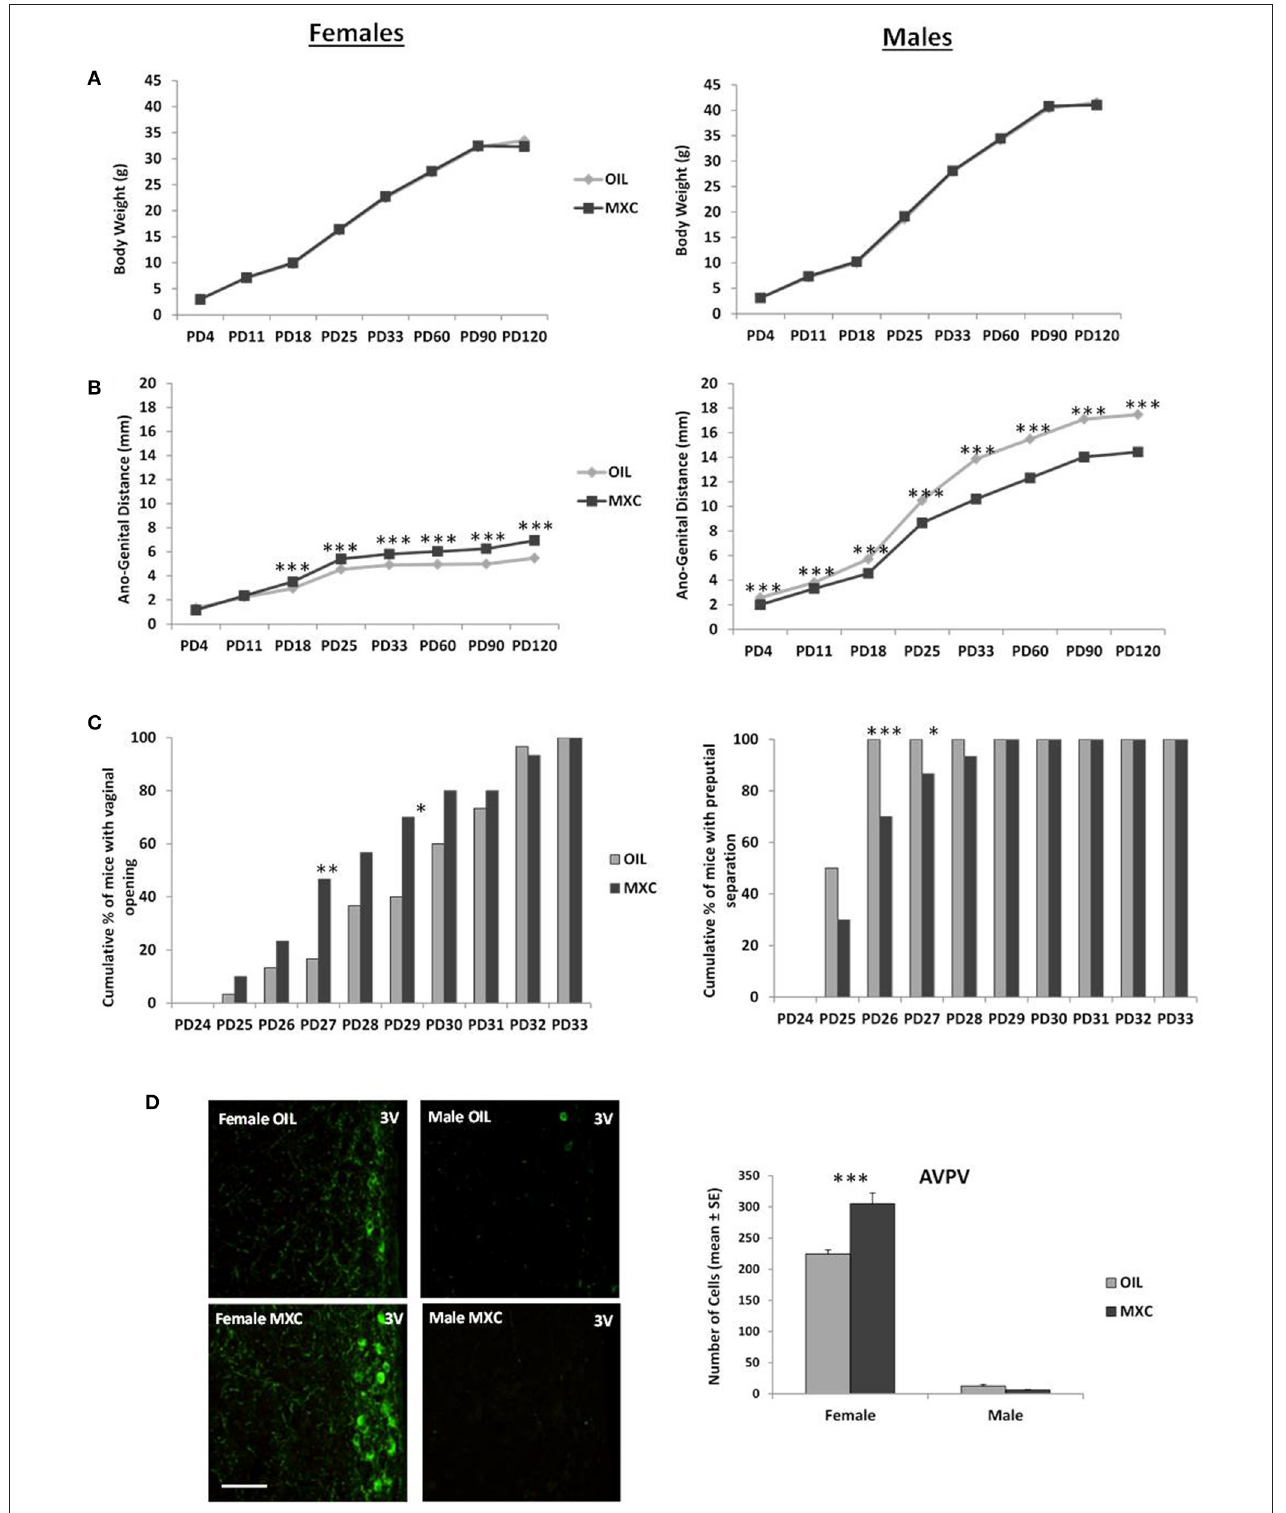
FIGURE 1 | Effect of perinatal exposure to MXC developmental parameters in both male and female mice. (A) Body weight gain from PD4 to PD120 shows no difference according to perinatal exposure to MXC or oil; (B) by contrast, ano-genital distance (AGD) between PD4 and PD120 was affected by MXC exposure, with a